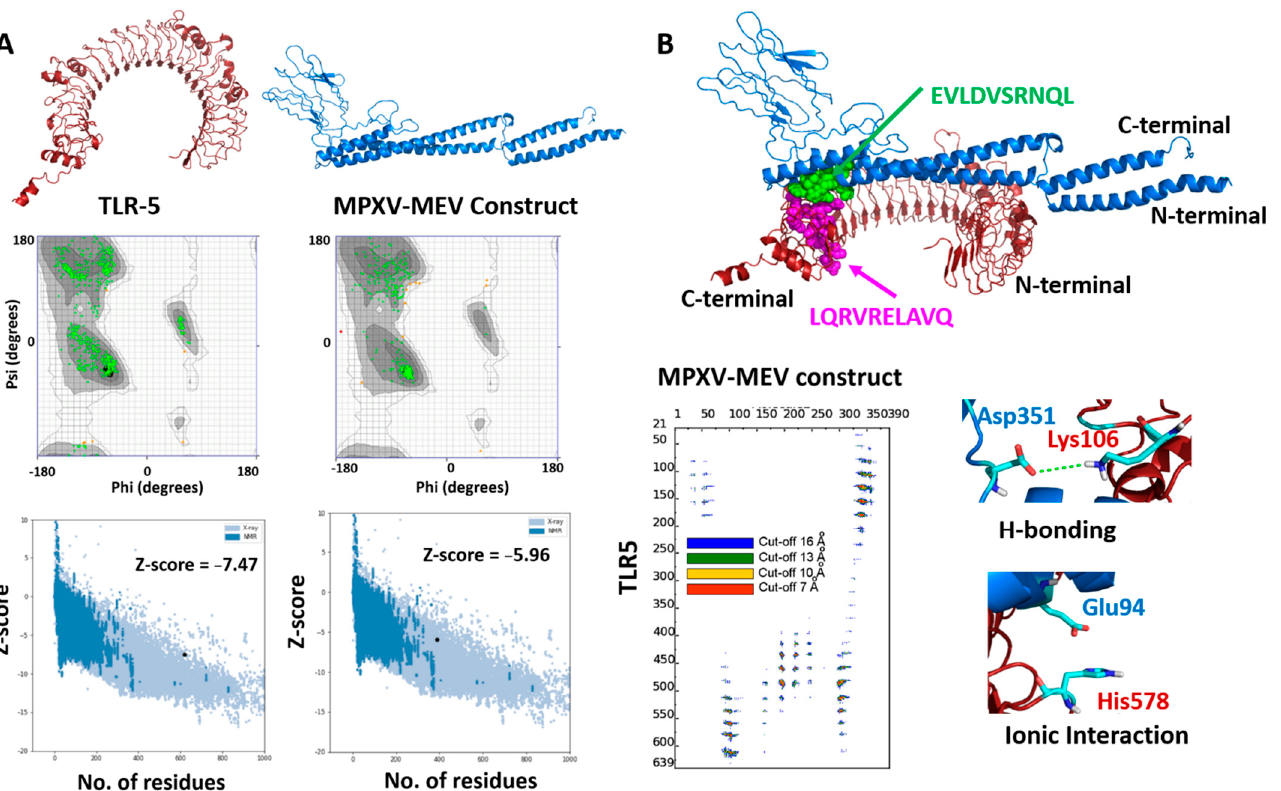
Figure 2. ( A ) Modeled 3D structures of ( A ) TLR5 and MPXY-MEV construct. Ramachandran plots and Z-scores calculated by Pro-SA webserver below the predicted structures. ( B ) Docked structure of MPXV-MEV and TLR5 as blue and red cartoons. The hotspot residues used for information-driven docking illustrated as spheres in green and magenta colors for the MEV construct and TLR5 receptor, respectively. Distance contact maps are also plotted, indicating the residues in contact between MPXV-MEV and the TLR5 receptor along with two representative molecular interactions between amino acid residues of TLR5 and the MPXV-MEV construct.